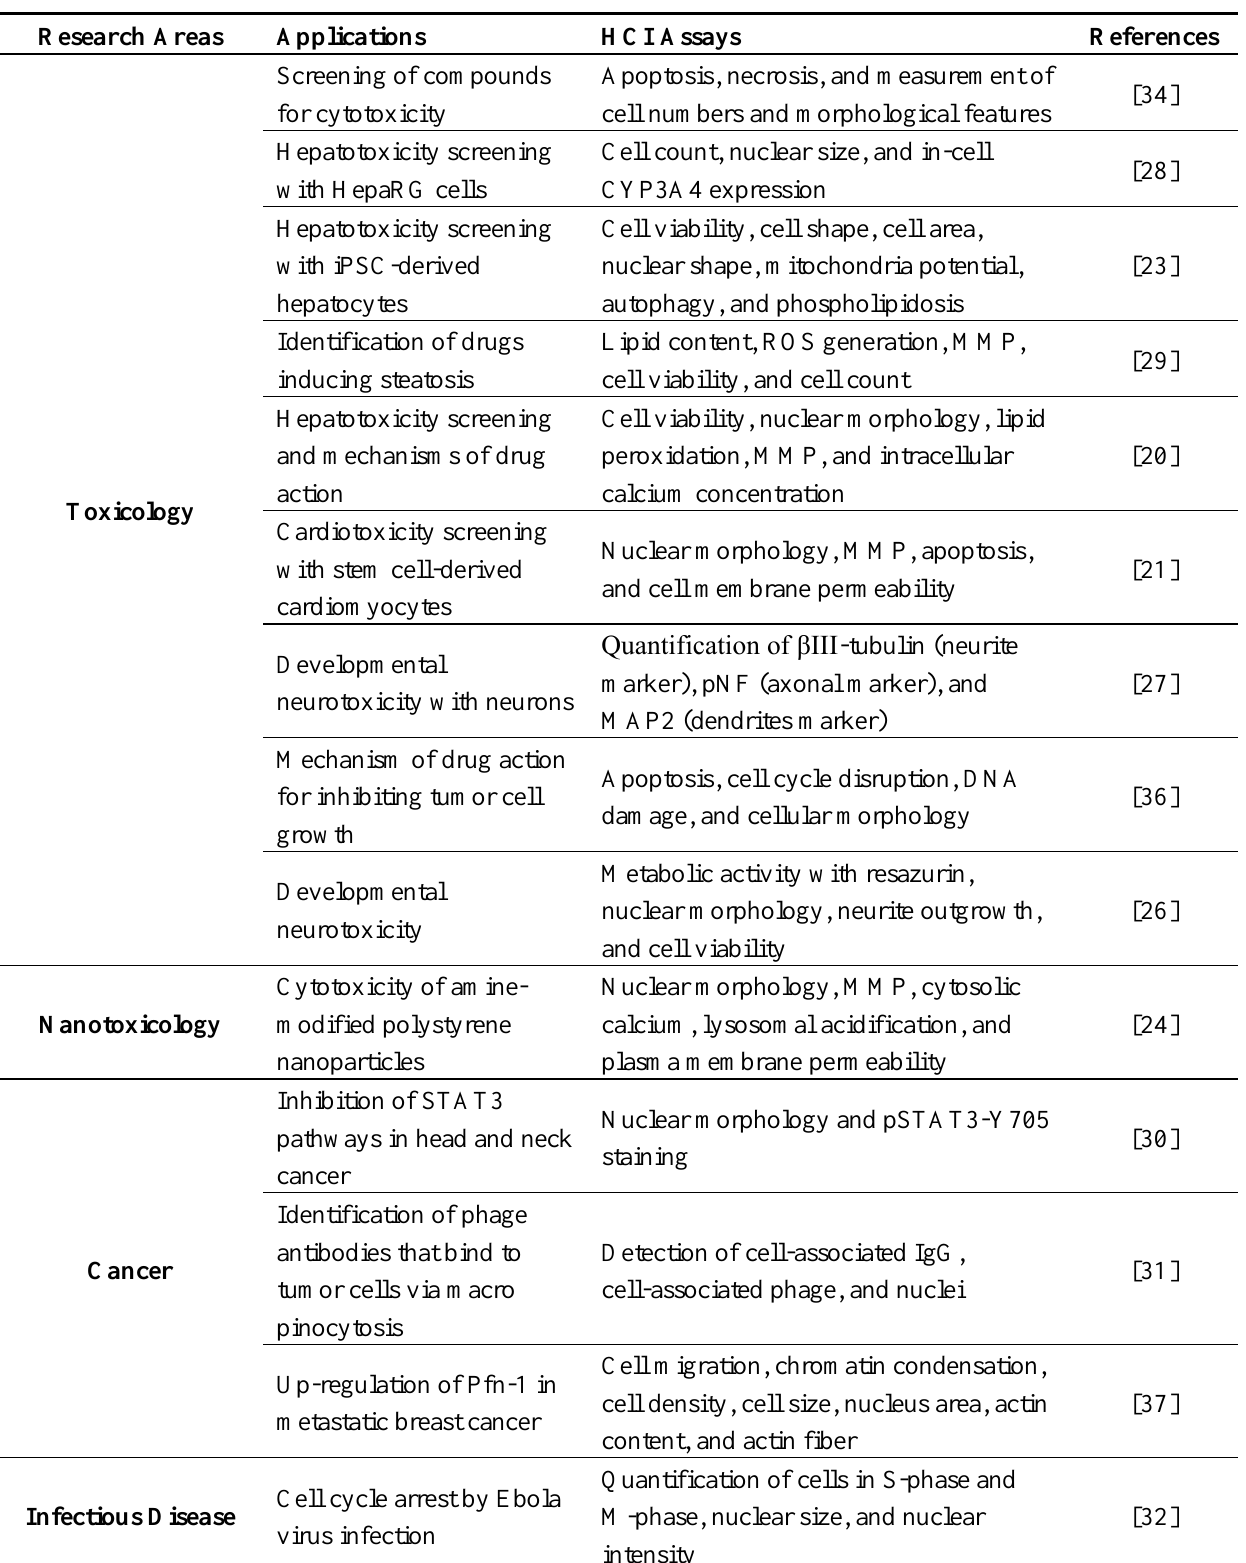
Table 2. Multiple parameters used in HCI assays and their applications in various areas of